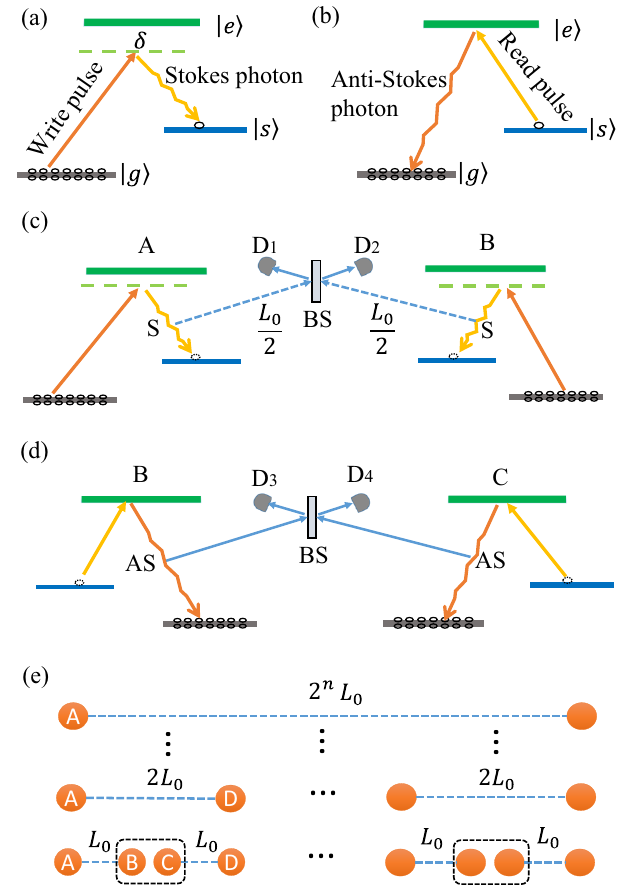
Fig. 1 Processes of the Duan – Lukin – Cirac – Zoller scheme. a Write process. An off-resonant laser pulse with detuning of δ to g j i ! e j i transition induces a Stokes (S) photon with a small probability. b Read process. A resonant laser pulse drives single excitation from s j i to e j i , inducing an anti- Stokes (AS) photon correlated with the Stoke photon. c Entanglement generation process. The stokes photons revealed by ensemble A and B interfere on a beam splitter (BS). d The fi rst level entanglement connection. e Extending the communication length by utilizing entanglement connection. The single-photon detector D 1 and D 2 are used to detect the Stokes photon in the entanglement generation process, while D 3 and D 4 are utilized to detect the anti-Stokes photon in the entanglement connection process. L 0 denotes the distance between two neighboring